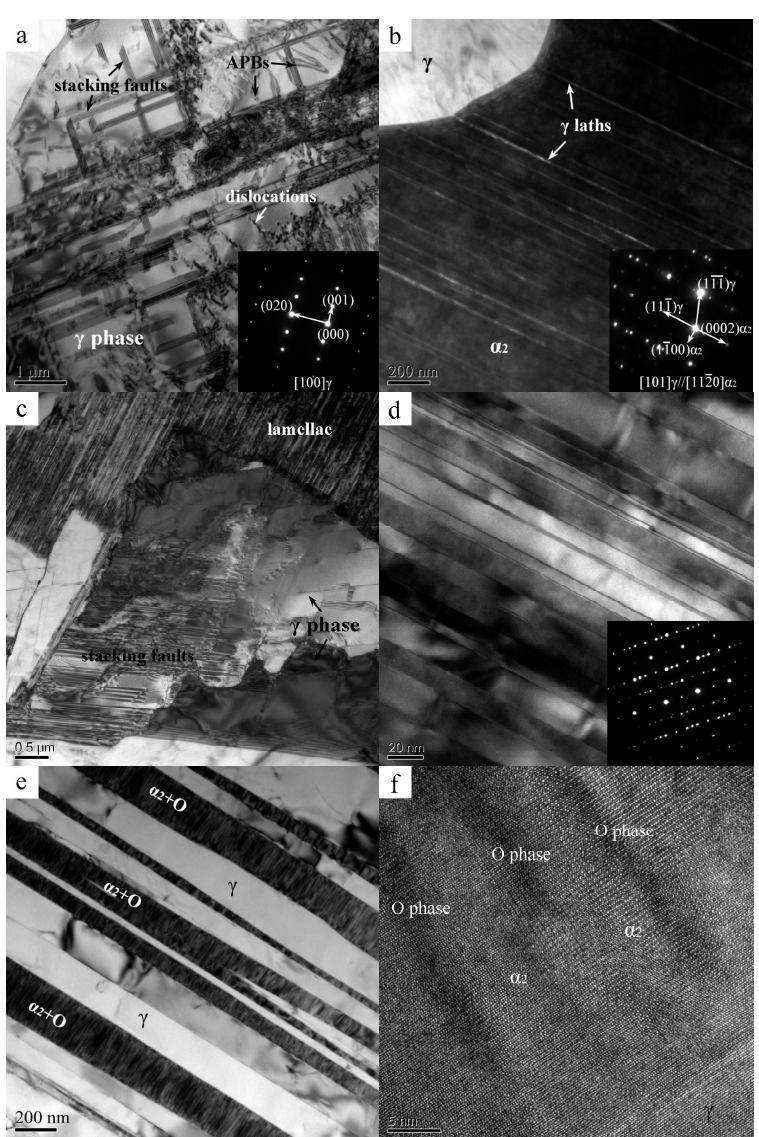
Figure 4. ( a , b ) TEM images of the microstructures after oil-quenching; note the various defects in the γ phase and the thin γ laths in Blackburn orientation relationship formed inside the bulk α 2 grains; ( c , d ) TEM images of the air-cooled sample; the gray contrast areas are actually extremely thin lamellar structures; ( e , f ) the α 2 laths in the furnace-cooled sample decomposed into a complex structure of α 2 + O phases; the HRTEM image displays the coherent or semi-coherent interfaces between O